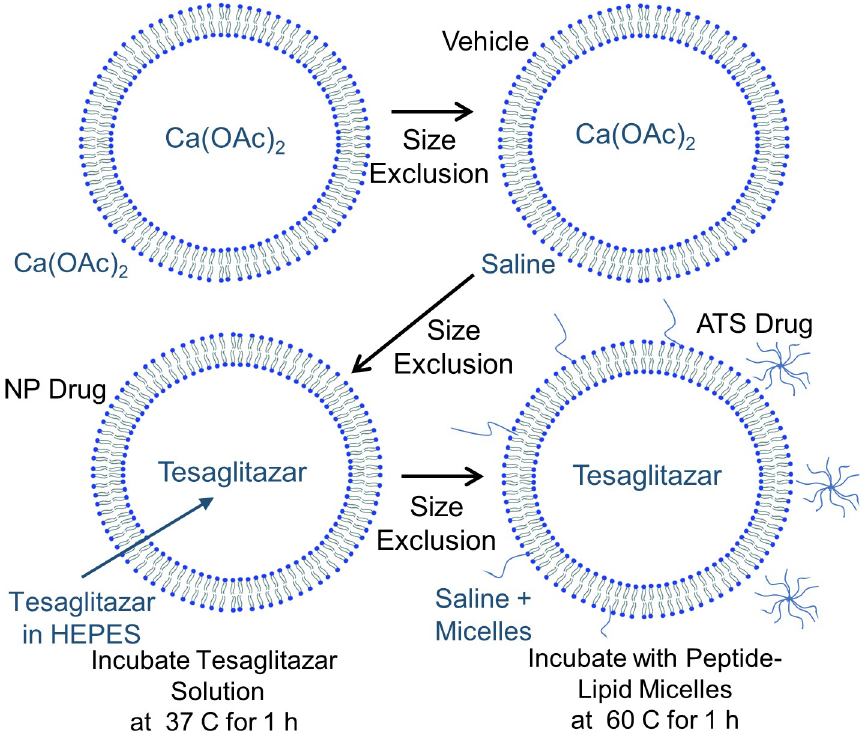
Fig 1. Targeted liposome synthesis. Liposomes were synthesized with reverse phase evaporation, loading them with a 1 M Calcium Acetate Ca(OAc) 2 solution in preparation for remote loading with PPAR agonist tesaglitazar. Liposome buffer exchanges from Ca(OAc) 2 to saline, to 3.3 mg/mL tesaglitazar in HEPES, and then back to saline were performed with size exclusion chromatography. Targeting peptides were then added to the liposomes with the post insertion method by incubating liposomes with peptide